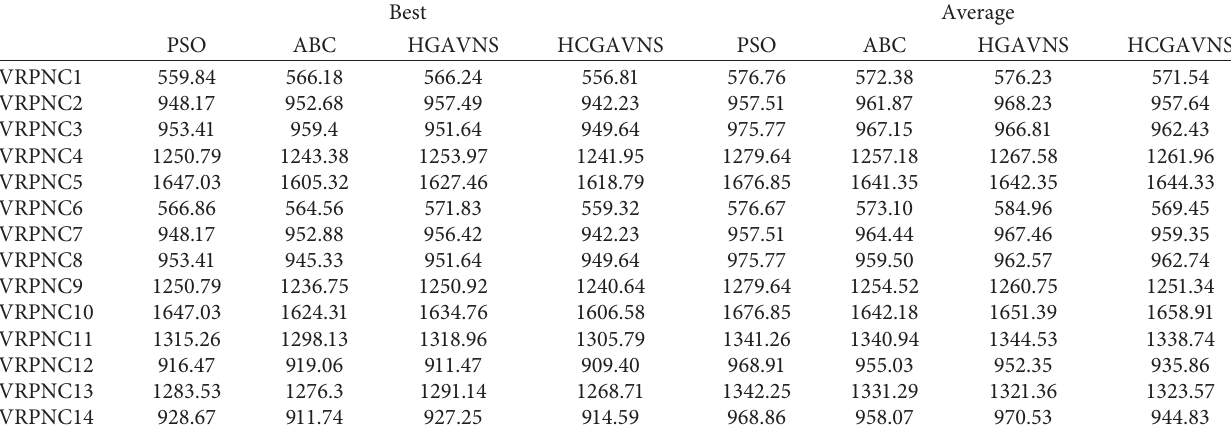
Table 4: Comparison of optimal results and average values of different algorithms.